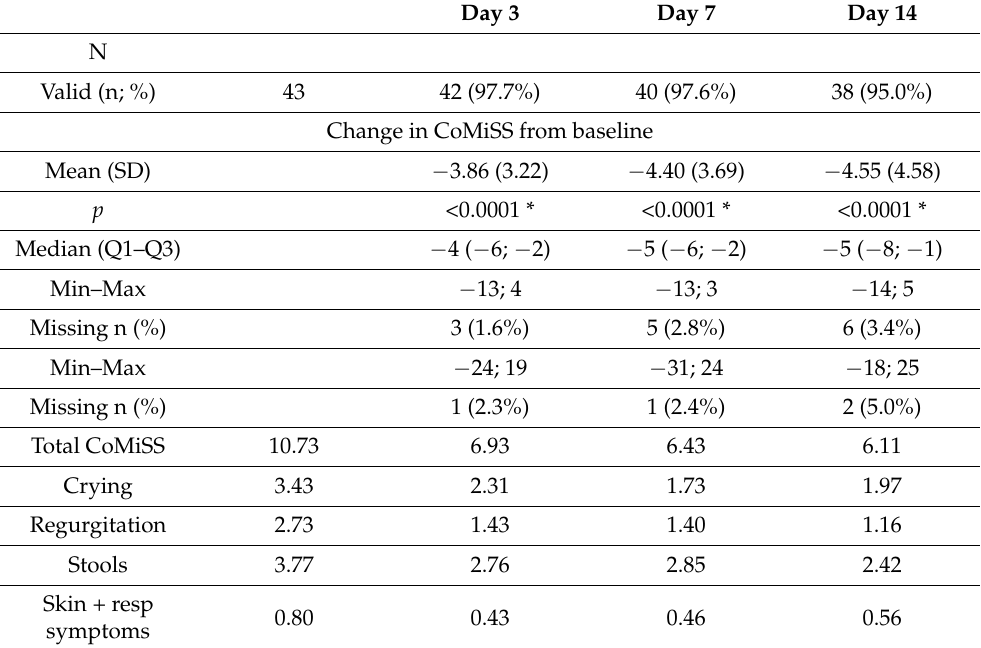
Table 7. The evolution of CoMiSS in the subgroup with CoMiSS > 9.